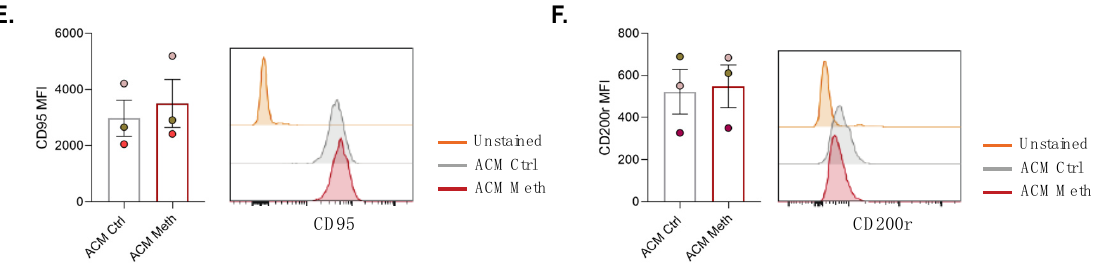
Figure 4. Neurons increased self-protection through contact-dependent mechanisms. RT-qPCR for ligand–receptor immunoregulatory pairs from microglia and neurons co-cultured in microfluidic devices, where microglial cells were exposed to ACM Ctrl or ACM Meth for 24 h. ( A ) Results for CD200 and CD200r, ( B ) CD22 and CD45, ( C ) CX3CL1 and CX3CR1, and ( D ) CD95. The results were normalized to the S18 gene and are expressed as the mean ± SEM of five independent cultures. Symbol colors represent the mean of each independent cell culture. Statistical analysis was performed using paired Student’s t -test (* p < 0.05). Quantification of ( E ) CD95 and ( F ) CD200r on microglia by flow cytometry, presented as median fluorescence intensity (MFI). Results are expressed as mean ± SEM of three independent cultures. Symbol colors represent the mean of each independent cell culture. Statistical analysis was performed using paired Student’s t-test. Representative histograms are shown; orange histogram represents unstained cells, gray the ACM Ctrl group, and red the ACM Meth group.